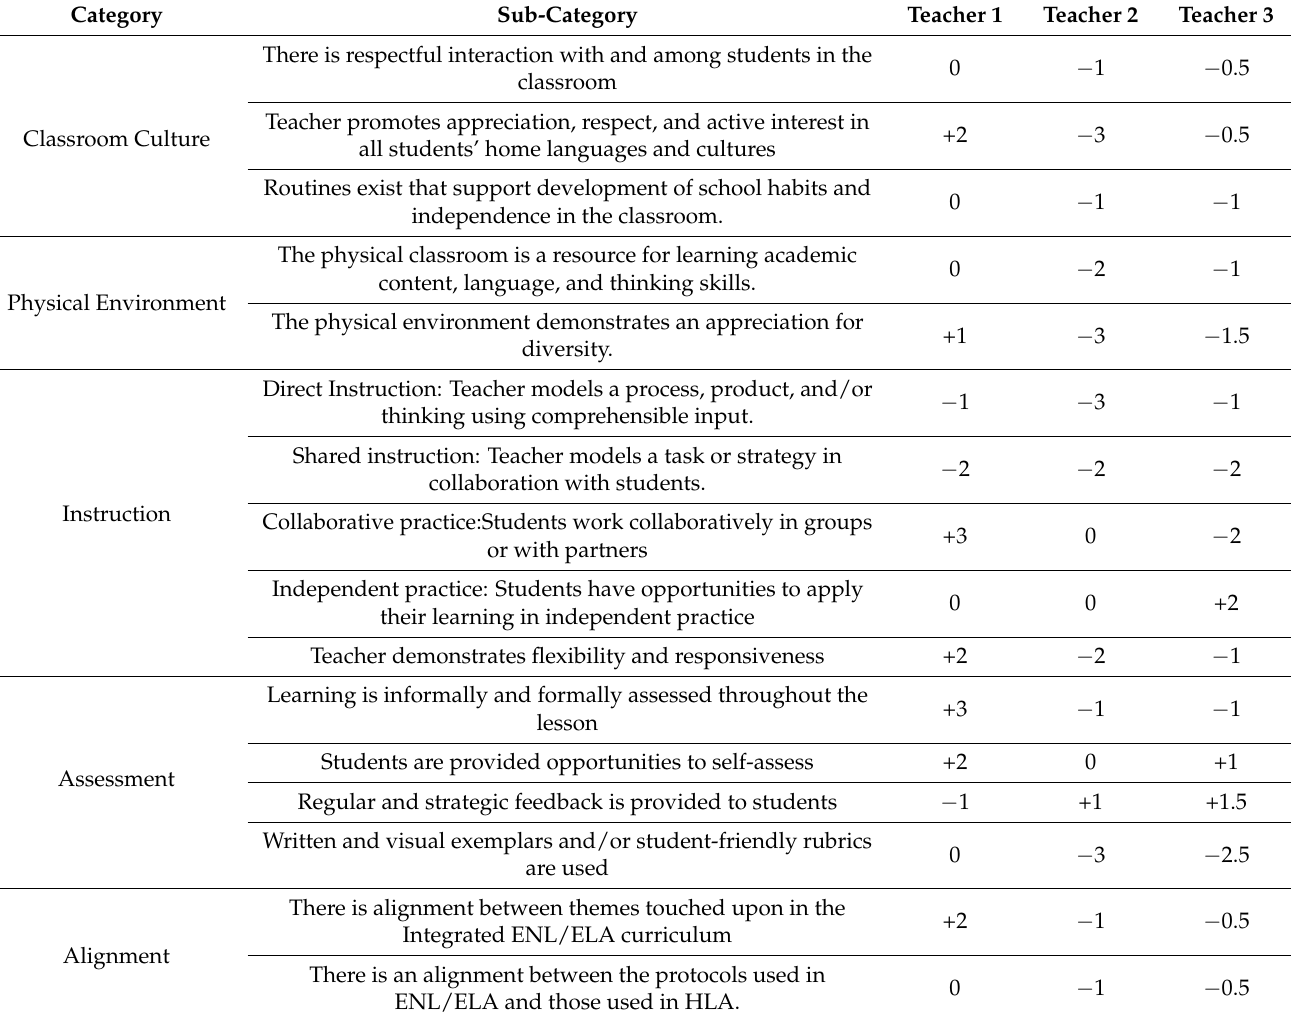
Table 3. Changes in Score Across Competencies Between Two Visits for Three Teachers.